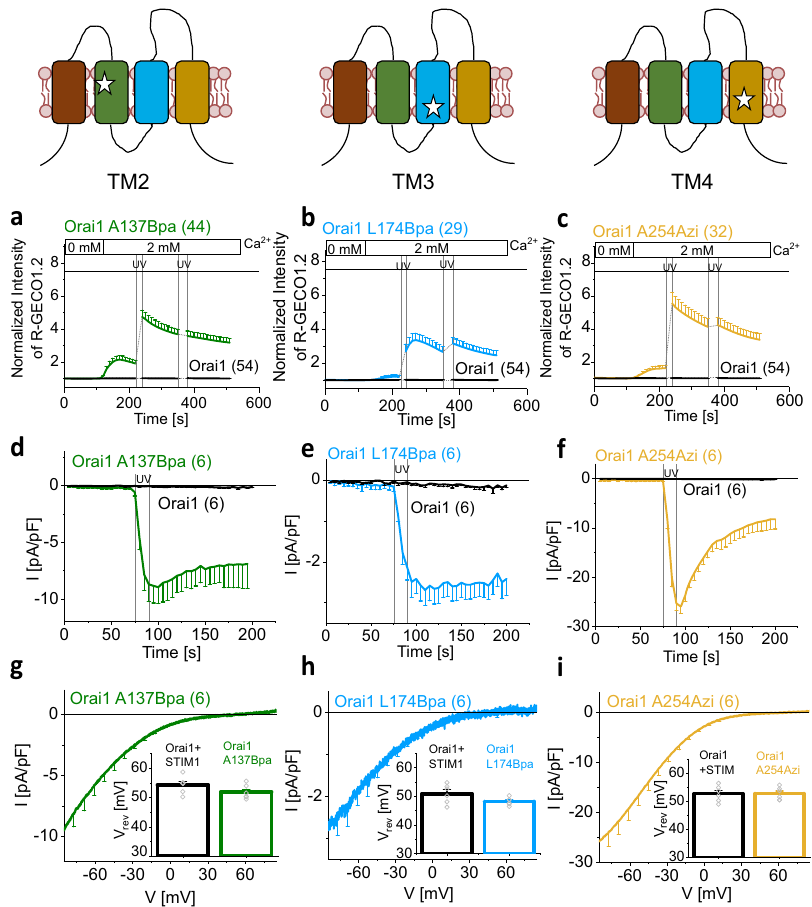
Fig. 2 | Photocrosslinking of Orai1 TM domains can lead to CRAC channel-like activation. Schemes show one Orai1 subunit representing either Orai1 A137Bpa, Orai1L174BpaorOrai1A254AziintheabsenceofSTIM1.StarsindicatesitesforUAA incorporation. Ca 2+ imaging measurements of Orai1 A137Bpa( a ),Orai1L174Bpa( b ) and Orai1 A254Azi( c )using R-GECO1.2. Intracellular Ca 2+ levels, represented bythe normalized intensity of R-GECO1.2 co-transfected with the above mentioned UAA- containing Orai1 mutants in HEK 293 cells, were monitored initially in 0mM Ca 2+ solutionfollowedbya2mMCa 2+ solution.Under2mMCa 2+ solutionconditions,UV light was applied for 10s and 30s, respectively. d – f Time courses of Ca 2+ current-